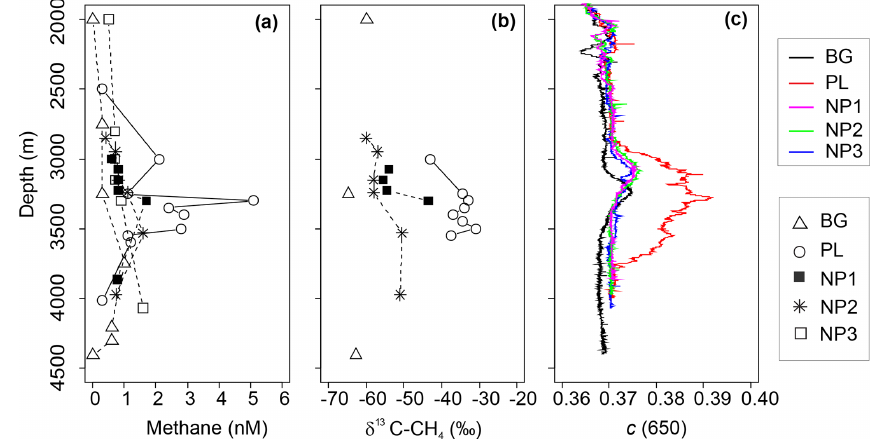
Figure 4. Depth profiles of (a) methane (CH 4 ) concentration, (b) δ 13 C-CH 4 values and (c) beam attenuation coefficient at 650nm (c) between 2000 and 4500m depths in background (BG), upper layer (UL), plume (PL) and non-plume (NP1–NP3)